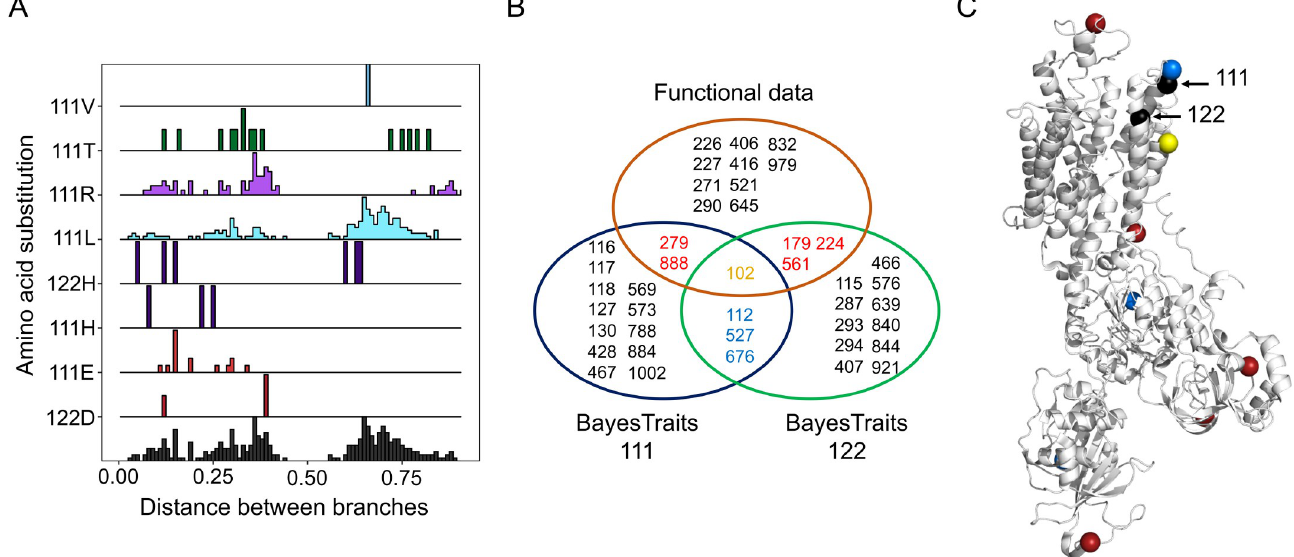
Fig 6. Phylogenetic patterns of convergence and amino acid co-variation (A) Distribution of amino acid substitutions at sites 111 and 122 across all paralogs. For each derived amino acid state at sites 111 and 122, the histograms show the distribution of pairwise convergent events along the sequence divergence axis (expected number of substitutions per site). Substitutions are color coded as in Fig 2. The histogram at the bottom shows the combined distribution of pairwise convergent events for both sites. (B) Intersection of 16 sites identified from functional data with the sites that most strongly correlated with substitutions at sites 111 and 122. Sites in the “Functional data” group correspond to the 16 sites from the two groups identified by the ANOVA model (S8 and S9 Tables). Sites in the BayesTraits analyses groups correspond to the top 5% sites with highest–log(P) association with 111 or 122, respectively. Overlaps between each group are larger than expected by chance: Functional \ BayesTraits111 = 3, P = 0.049; Functional \ BayesTraits122 = 4, P = 0.007; BayesTraits111 \ BayesTraits122 = 4, P = 0.011. (C) Crystal structure of ATP1A1 (PDB 3B8E) showing sites color coded according to the intersections in panel B and sites 111 and 122 as black spheres.